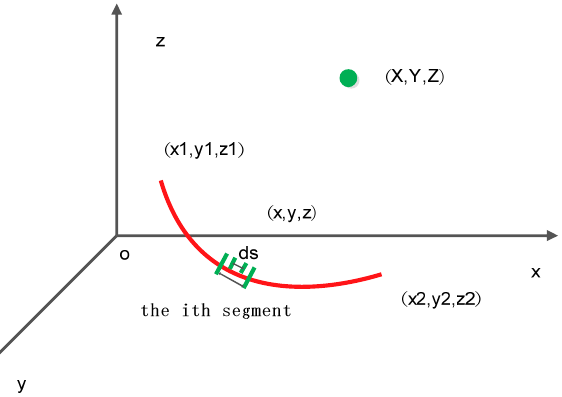
Figure 1. Schematic diagram of the horizontal well in the unbounded formation. The horizontal well is equally divided into m segments according to its length. It can be seen that when m is large enough, each segment can be approximated as a straight line segment with the length of L . The start coordinate of each segment is ( x si , y si , z si ) and the m end coordinate is ( x ei , y ei , z ei ), where i = 1, 2, 3... m . Take any point in one segment with coordinates ( x , y , z ) as the end point, and the distance from the beginning of the segment